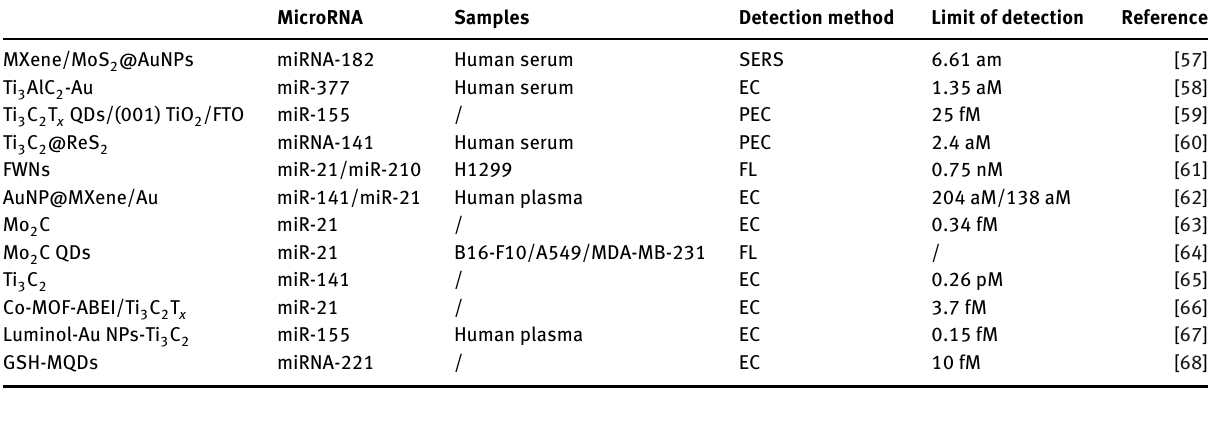
Table 1: 2D MXenes applied for microRNA detection.